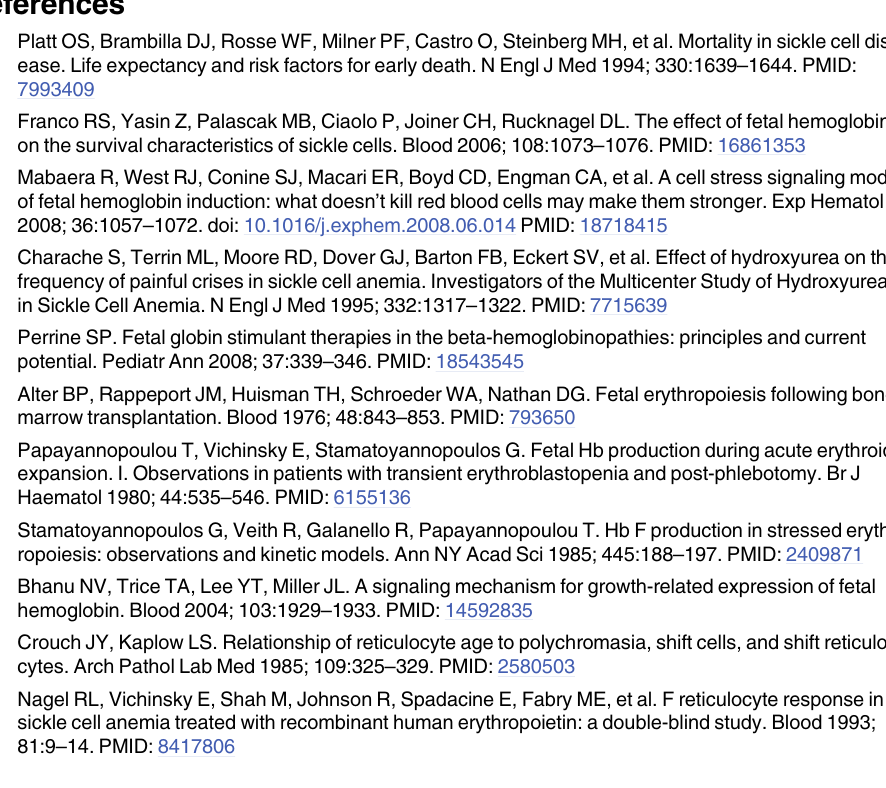
S1 Fig. Non-age stratified hematologic data for the entire cohort. Correlation of A. HbF (%), B. Hb (g/dL), C. F-cells (%), D. ARC (K/ μ L) with age in years. HbF, Fetal hemoglobin; Hb, hemoglobin; ARC, Absolute Reticulocyte Count. Each dot represents a steady state value for a separate